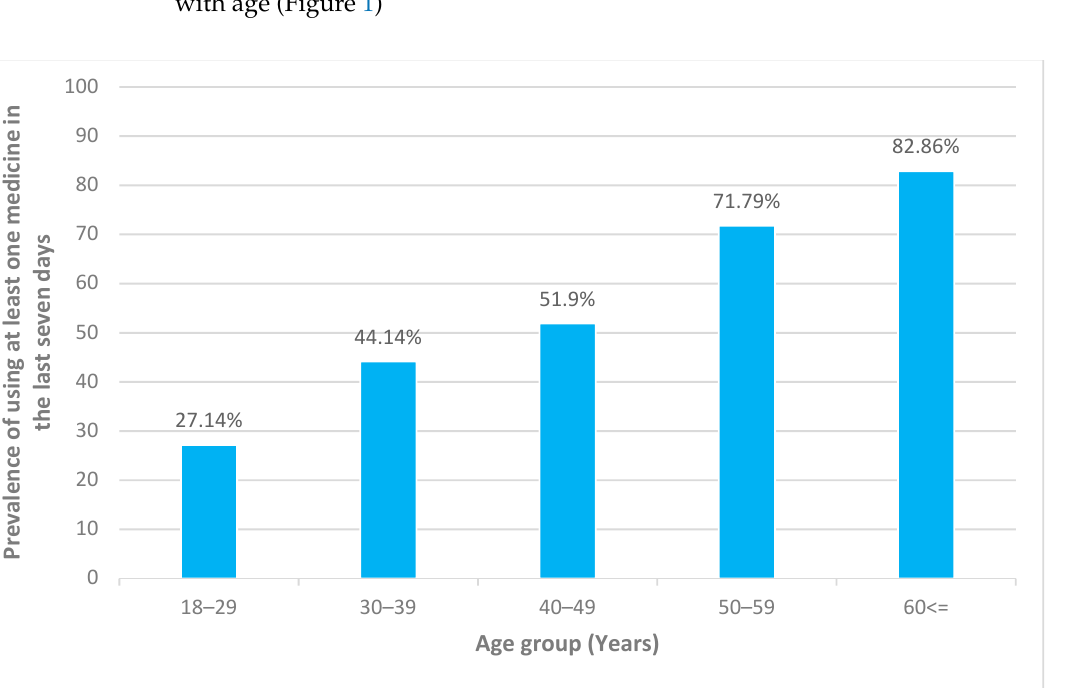
Figure 1. Prevalence of using at least one medicine in the last seven days among adult participants in each age group.